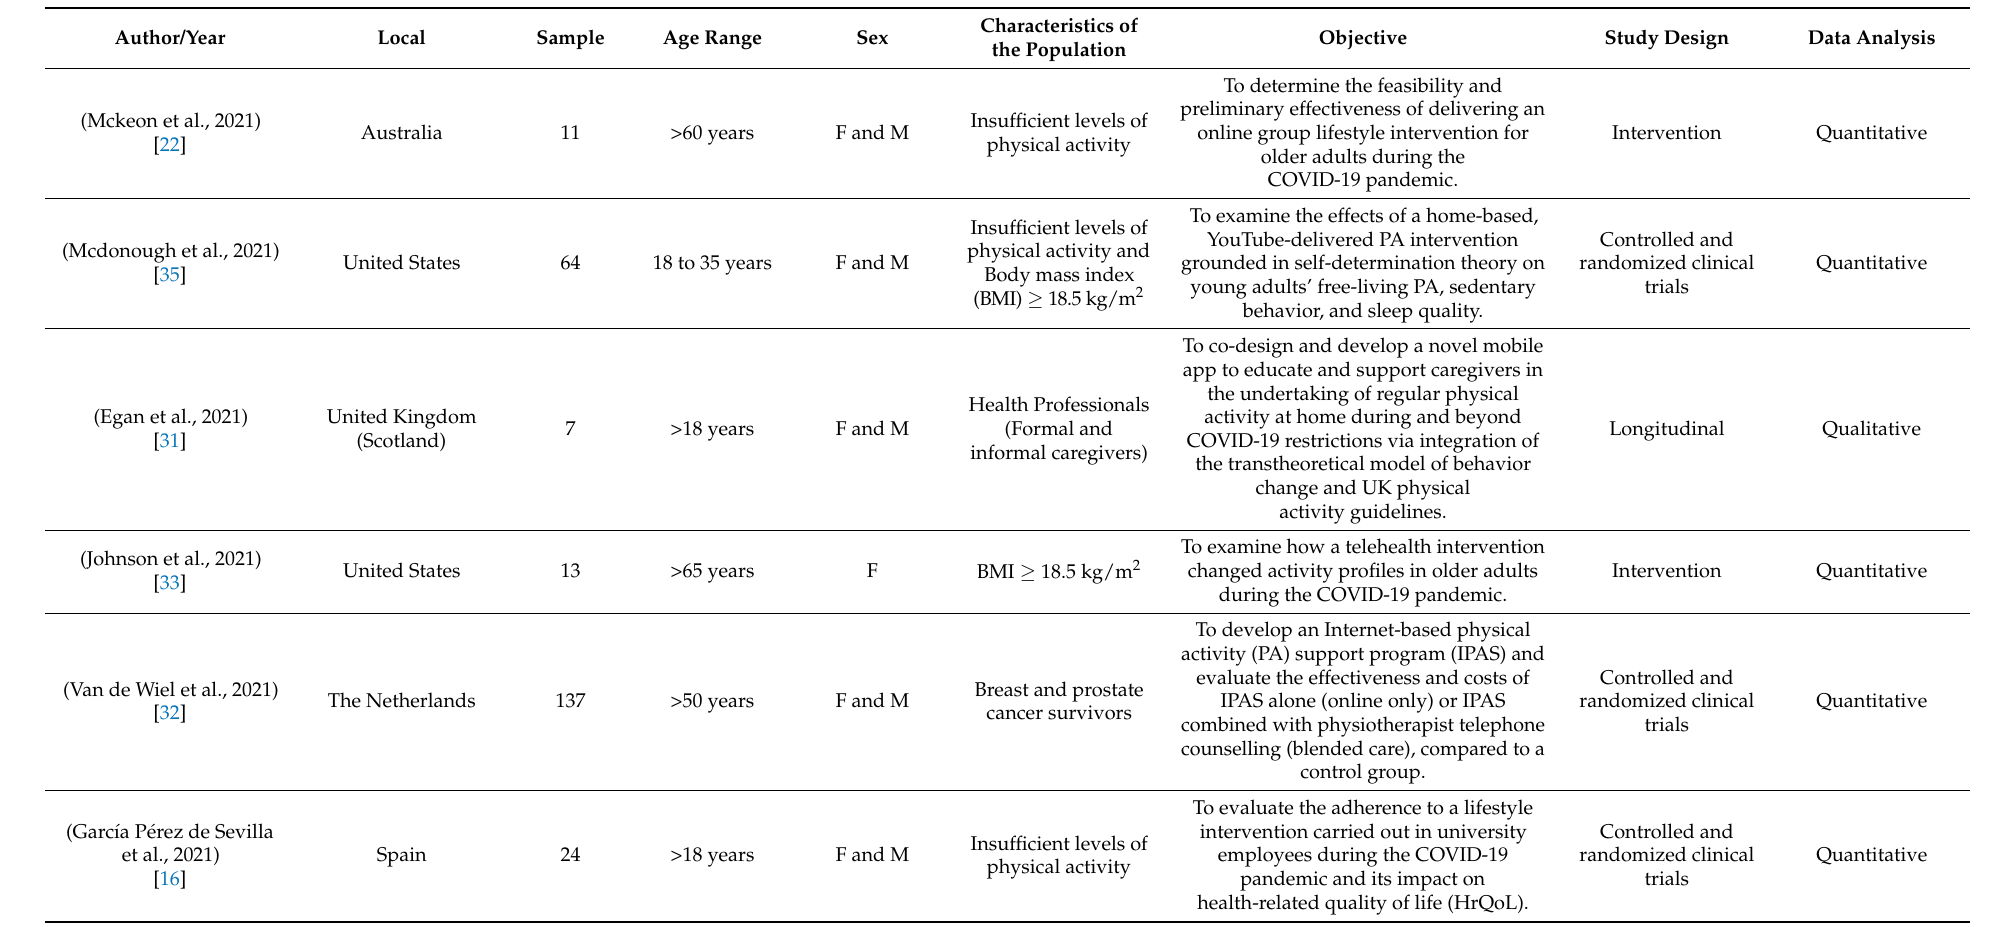
Table 1. Descriptive characteristics of the scoping review studies on counseling for physical activity during the COVID-19